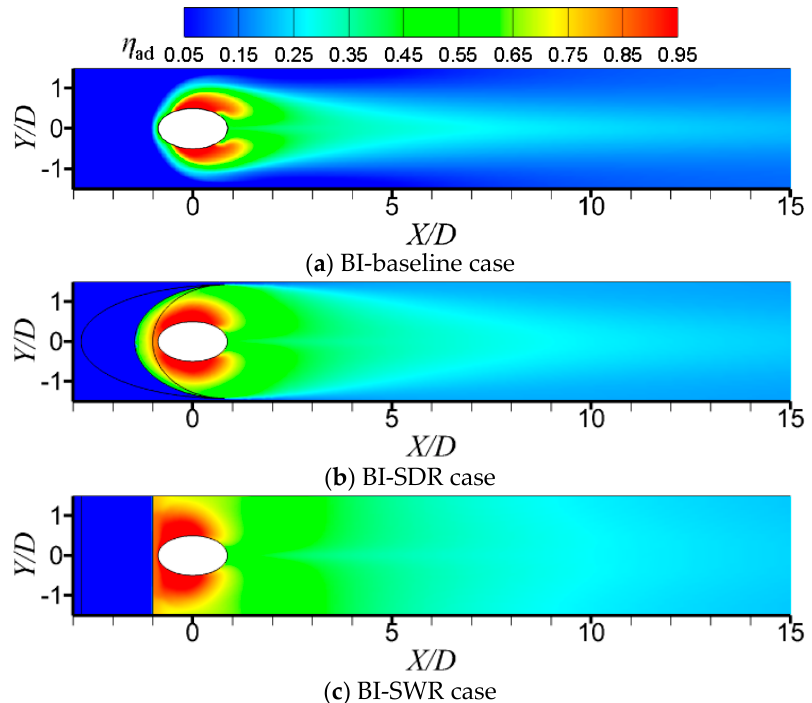
Figure 13. Adiabatic film cooling effectiveness distributions in BI cases under M = 1.0.